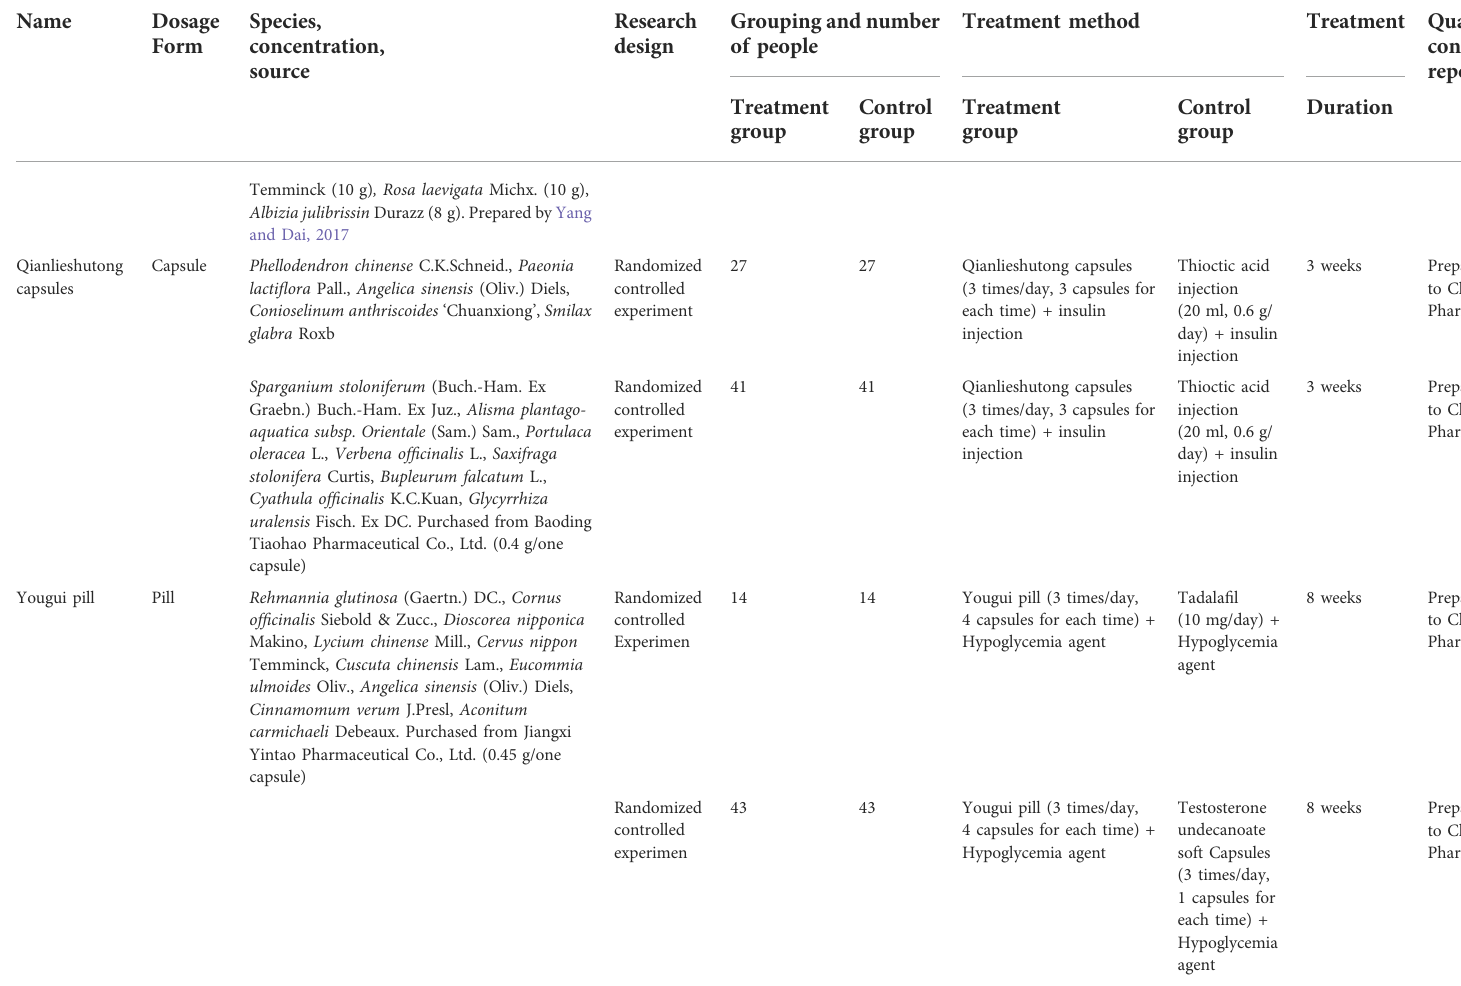
TABLE 1 ( Continued ) Summary of the prescribed formulae and natural products from Traditional Chinese medicine used in clinical